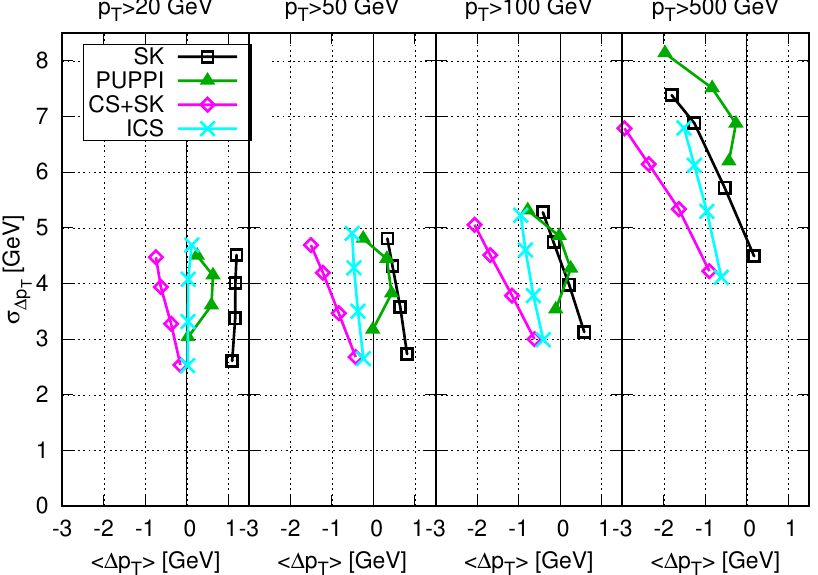
Figure 9. Comparison of the jet p T resolution as a function of jet p T bias for four methods: SoftKiller, PUPPI, CS+SoftKiller and ICS. Dijet events are used with di(cid:11)erent jet p T cut in each panel. Each curve corresponds to a di(cid:11)erent method and the 4 points on each curve correspond to N PU = 30, 60, 100 and 140 from bottom to